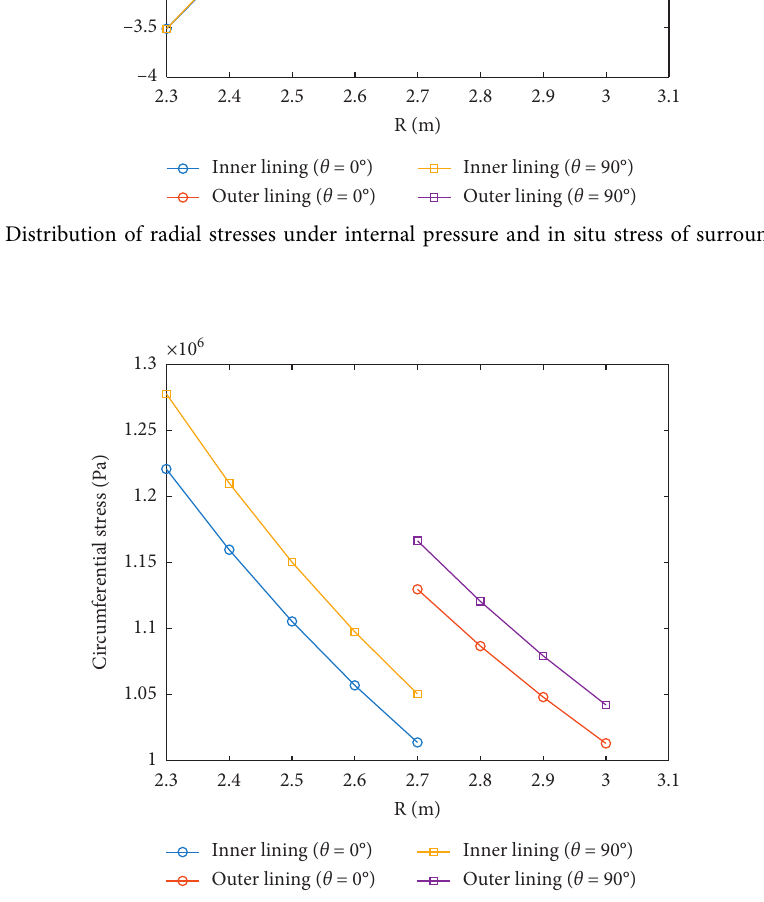
Figure 10: Distribution of circumferential stress under internal pressure and in situ stress of surrounding rock.